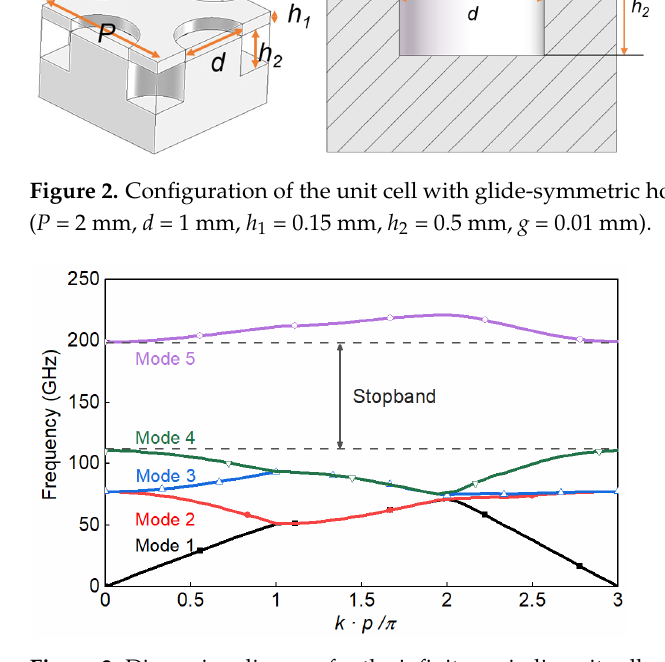
Figure 4. Simulation model of the air-filled GWG, based on the glide-symmetric holey EBG. After stacking the top and bottom layers, a rectangular GWG line with the dimen- sions 1.65 mm × 0.82 mm × 15 mm is formed; it is compatible with the standard WR-6.5 waveguide in the D band. Periodic rectangular slots along the groove channel are opened to decrease the wave travelling in the small gap between the two layers, as explained in [22]. CST Microwave Studio is used for the simulations. High-conductivity metal alumi- num with dimensions of 3.56 × 10 7 S/m is used during the simulation, and the simulated results are shown in Figure 5. With a gap distance from 0.01 mm to 0.03 mm, the relatively wide bandwidth shows good tolerance adaptivity with the designed EBG-based wave- guide. When the gap is designed to be 0.01 mm, the reflection coefficients are below − 28 dB in the whole D band, and below − 40 dB for most of the band. The simulated transmis- sion coefficient is better than − 0.2 dB for almost all of the D band.